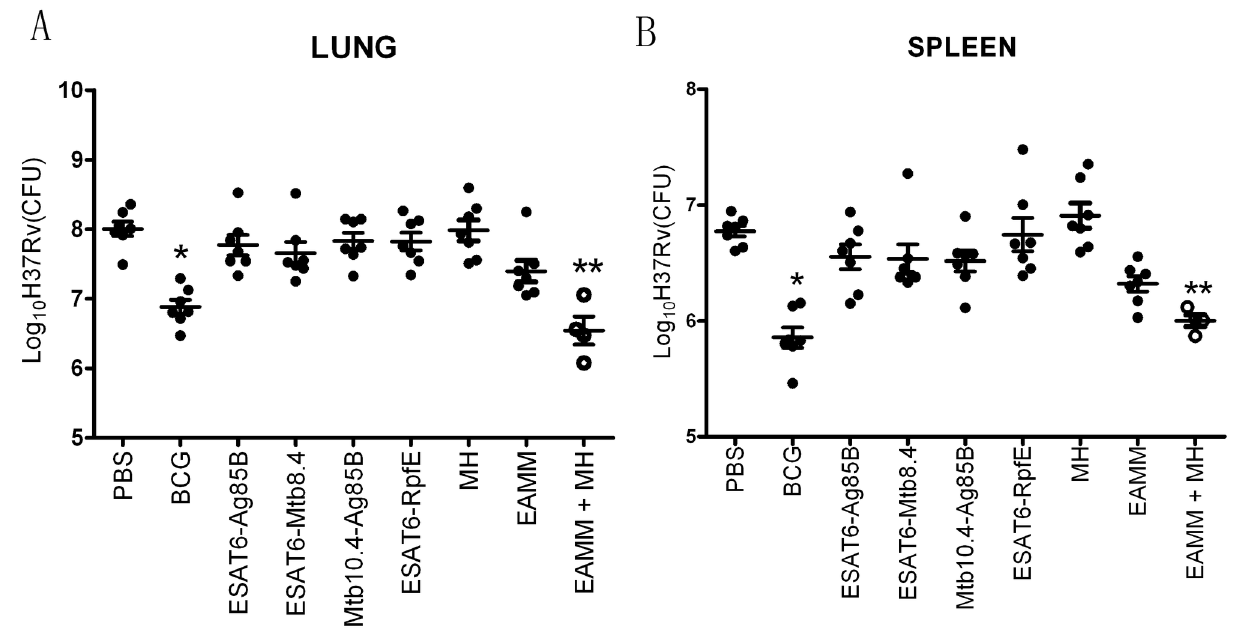
Figure 3. Protective efficacy of subunit vaccine candidates against M. tuberculosis infection. The mice received three times of inoculation with the protein vaccine candidates in DDA/Poly(I:C)/Gelatin. The vaccinated mice were challenged with virulent M. tuberculosis 10 weeks after the final vaccination. Six weeks after challenge with virulent M. tuberculosis , the animals were sacrificed, and the numbers of CFU of M. tuberculosis in the lungs (A) and spleens (B) were determined. Results are presented as mean ± SD, n = 4 or 7. p < 0.05 vs . PBS. ** p < 0.05 vs. PBS, EAMM and MH. doi: